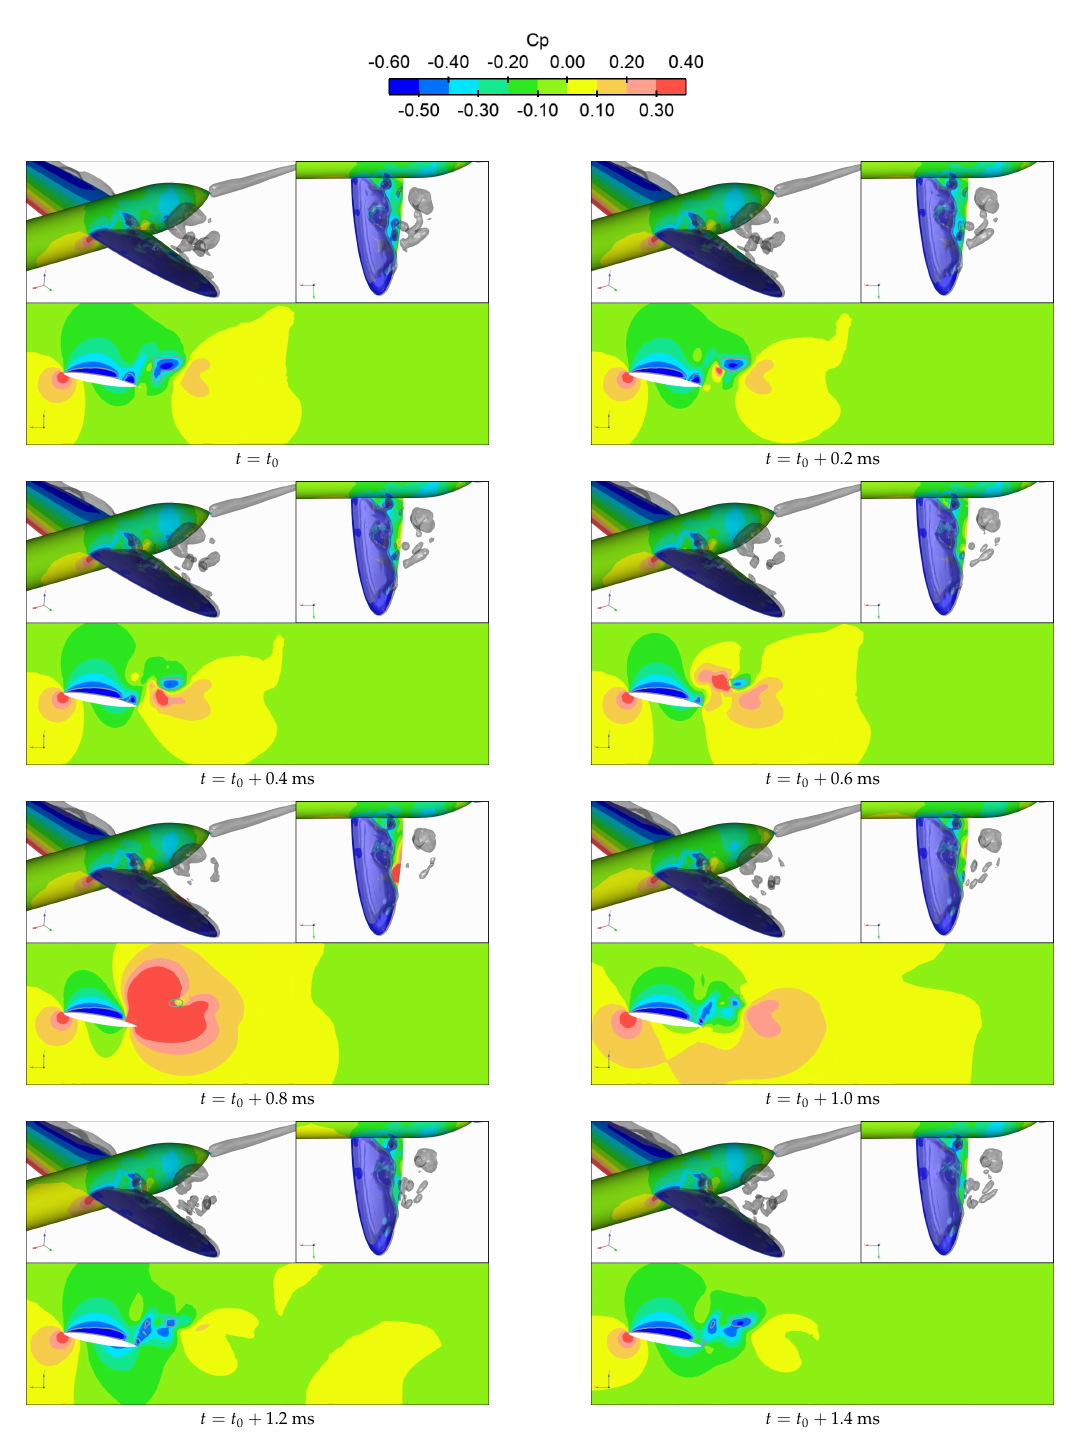
Figure 17. A sequence of snapshots visualizing a collapse event of the cavity. DDES with medium grid, σ = 0.53. Top frames show the left wing from the side and the top, and the bottom frame shows a cut plane at mid-span. The cavitator and the cut plane are colored by C p